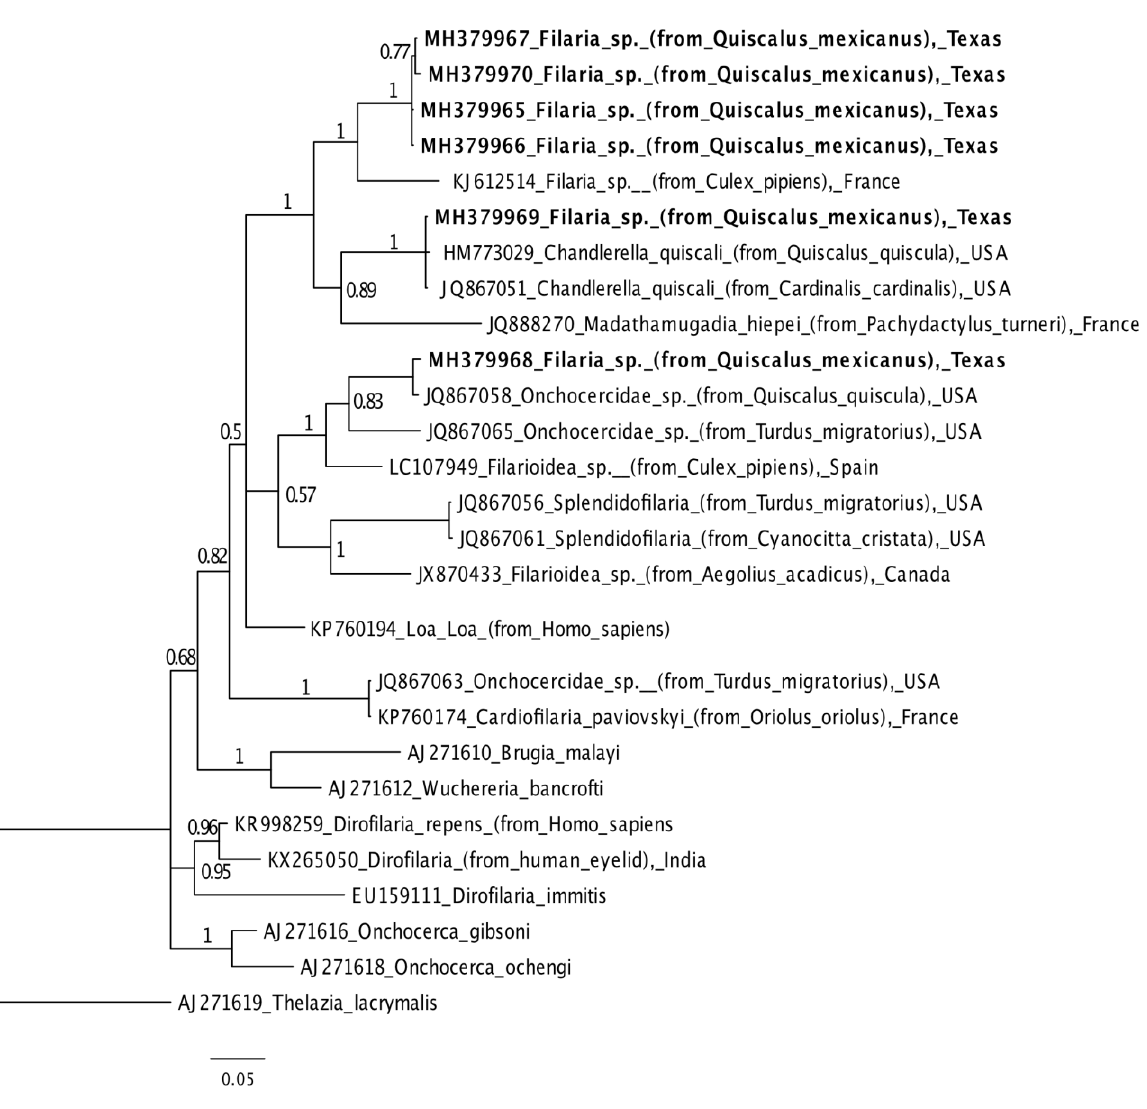
Figure 1. A phylogenetic tree constructed from a 527 base pair segment of filarial nematode DNA inferred using mito- chondrial cytochrome oxidase 1 gene sequences from 27 organisms using Thelazia lacrymalis (GenBank: AJ271619.1) as an outgroup. Filarial nematode sequences from great-tailed grackles captured in College Station, Texas are listed in bold font.